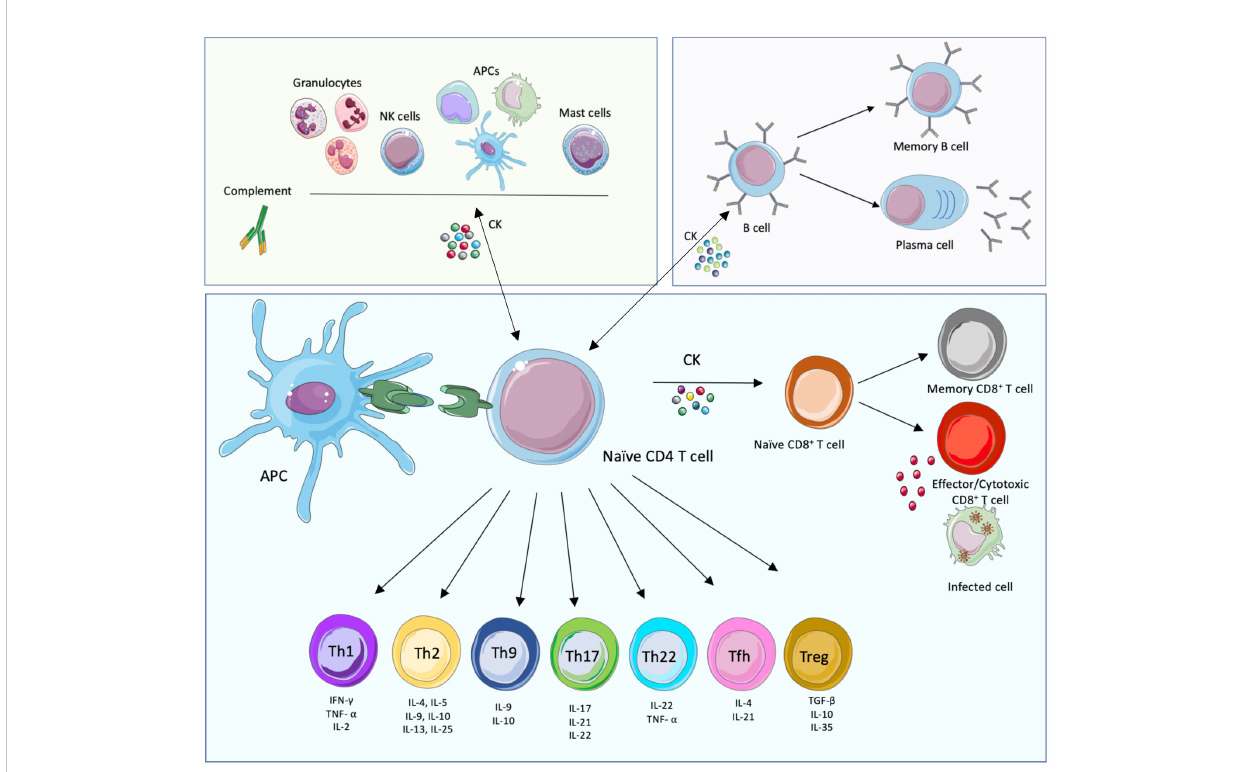
FIGURE 1 Innate, humoral and cellular-mediated immune responses. The main cellular immune players of the cell-mediated innate (green background, top left), humoral (purple, top right) and adaptative cell-mediated (blue, bottom) immune responses and their interconnections are displayed. The components of the innate immune system provide, together with their effector functions and soluble mediators, an immediate response to pathogens. This response triggers in turn the adaptive immune system, mostly T cell-mediated immune responses that lead to the activation of effector T cells and the activation of B cell functions. This branch of immunity provides speci fi c, long-lasting immune responses. The adaptive and innate immune systems are connected; importantly, while soluble mediators are important to link both arms of immunity, the presentation of foreign peptides (in green) by Antigen Presenting Cells (APCs) is also necessary, together with immune mediators such as cytokines (CK). This fi gure was created with